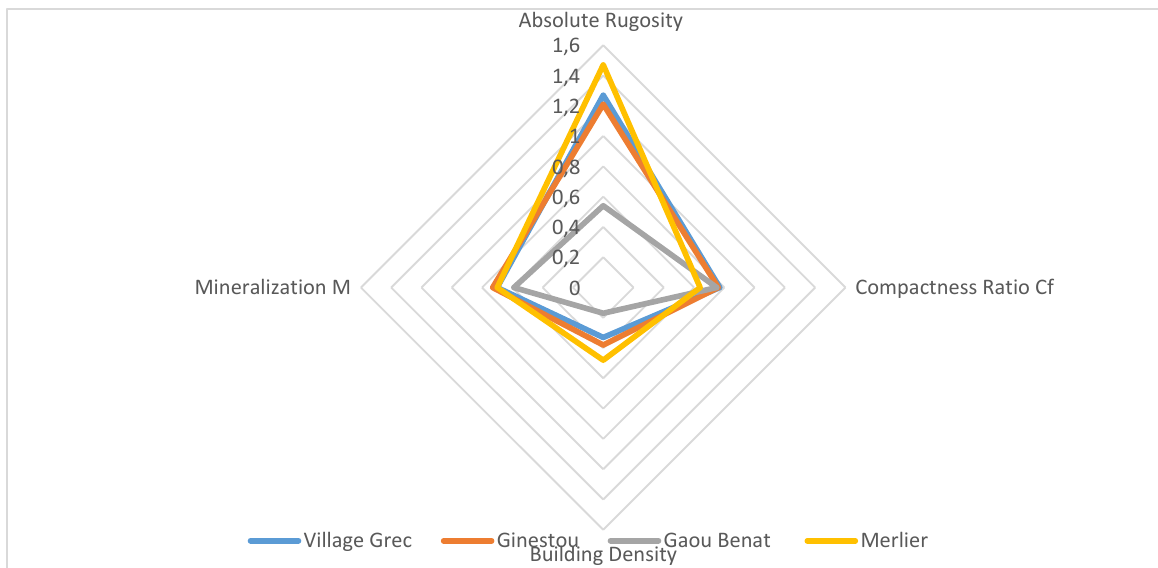
Figure 7. Case study comparison. The residences with the most positive effect in hot summer conditions are the ones with the lower values. Gaou Benat stands out because the wind has fewer obstructions (low Absolute Rugosity) and it’s greener (low mineralization). Merlier stands out because it has the lowest Compactness